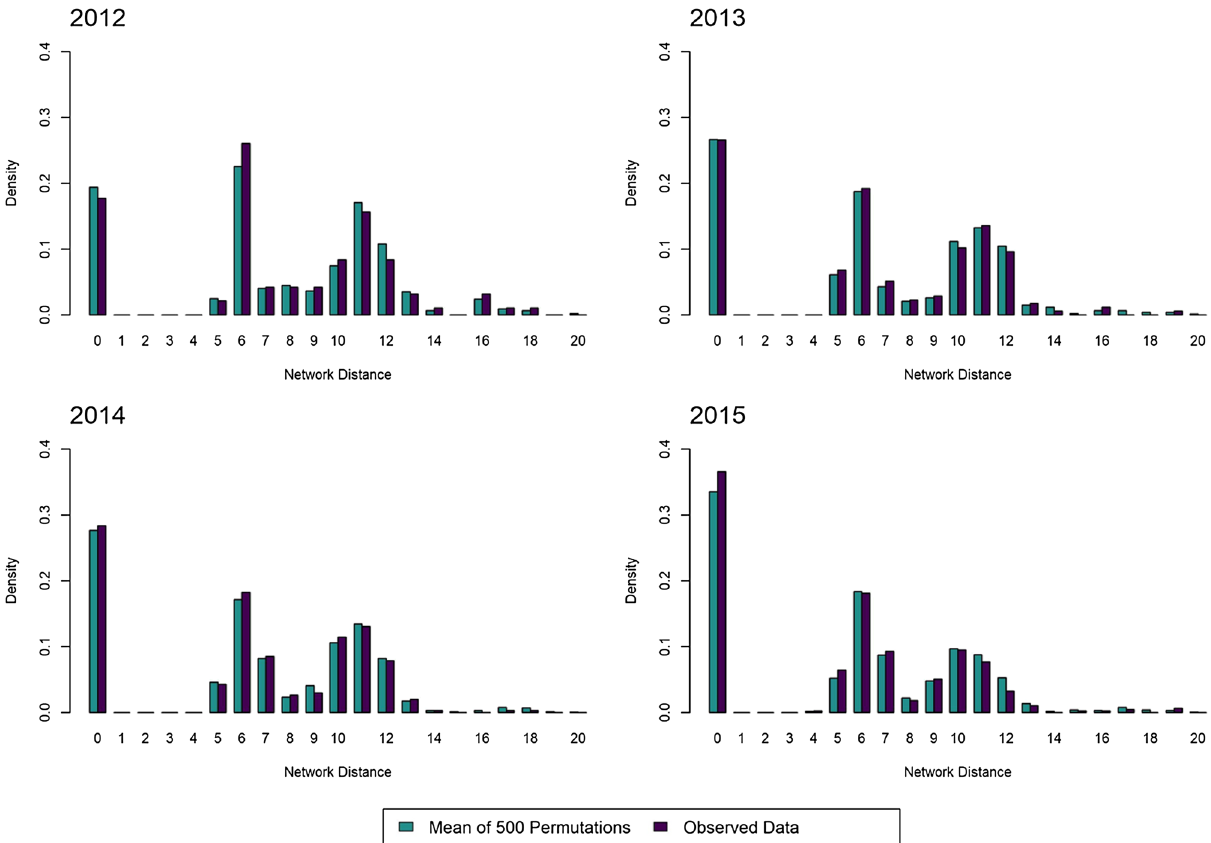
Figure 2. Comparison of the distributions of network distances for observed vs. permutated data, 2012–2015. For each year, the density distribution of distances between incident episodes and their potential infector in the observed data is shown; as well as the density distribution of the mean distances computed based on 500 random permutations of the data, illustrating the distribution expected under the null hypothesis of independence between patient transfers and CPE incidence. Distances of zero correspond to linked episodes occurring in the same county. Distances of one correspond to a range of distances between zero and one; the same applies to distances of